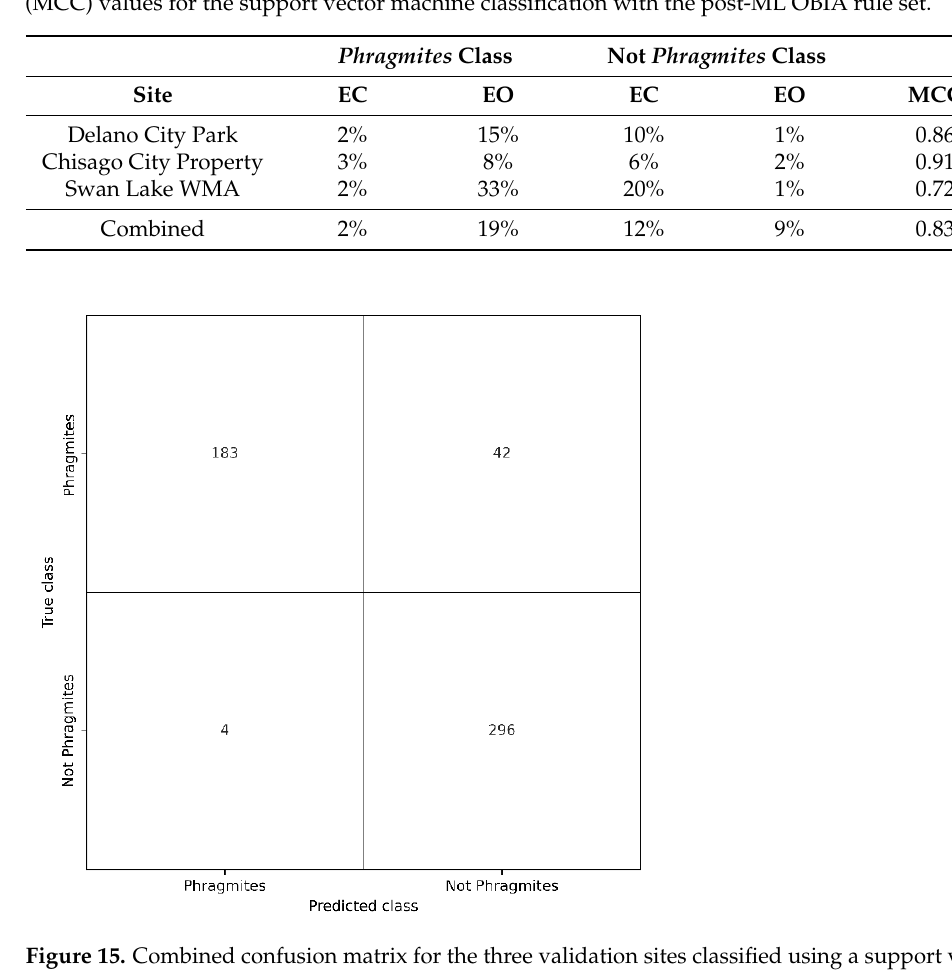
Figure 15. Combined confusion matrix for the three validation sites classified using a support